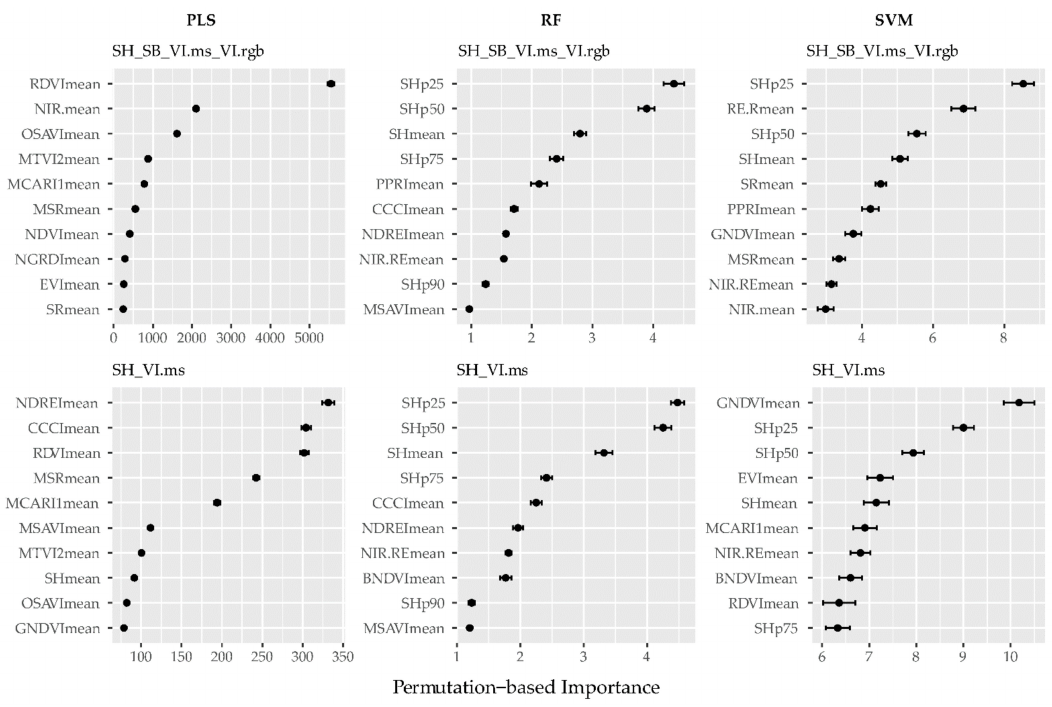
Figure 19. Variable importance plots of best models (10 most important variables shown) for N-uptake